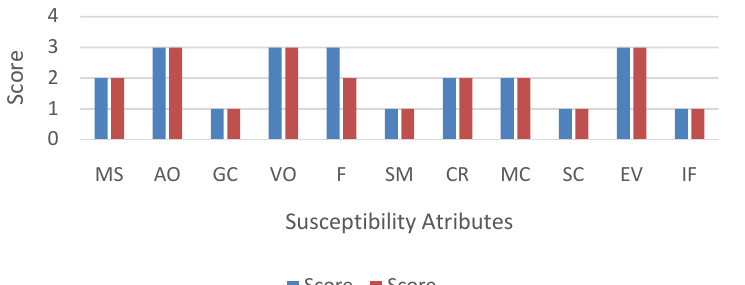
Fig. 4: Score of Plectropomus areolatus and Plectropomus leopardus based on Susceptibility Attributes. MS, Management strategies; AO, Areas of overlap; GC, Geographic concentration; VO, Vertical Overlapping; F, Fishing mortality; SM, Seasonal migration; CR, Clump or custom response; MC, Morphology affect catches; SC, Survival after capture; EV, Economic value; IF, The impact of fishing gear on